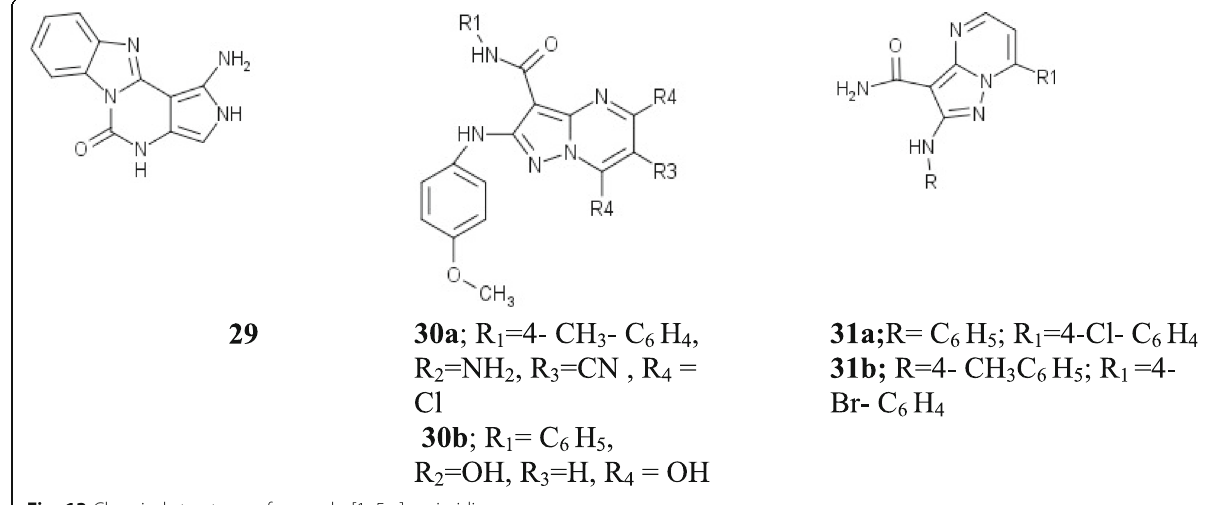
Fig. 13 Chemical structures of pyrazolo [1, 5-a]